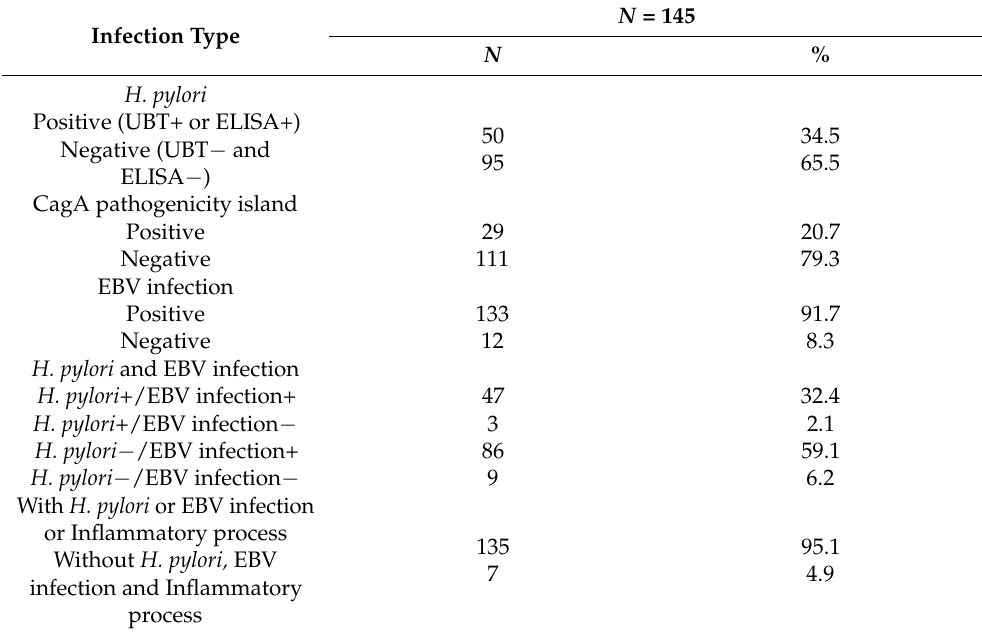
Table 2. Frequency of infection by H. pylori and/or by Epstein–Barr Virus